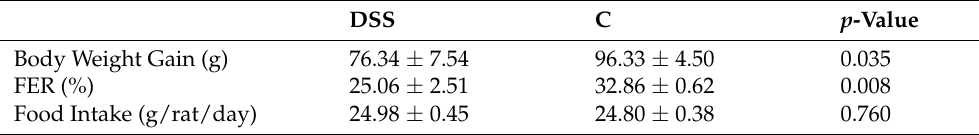
Table 2. Effect of dextran sulphate sodium (DSS) on body weight gain, food efficiency ratio, and food